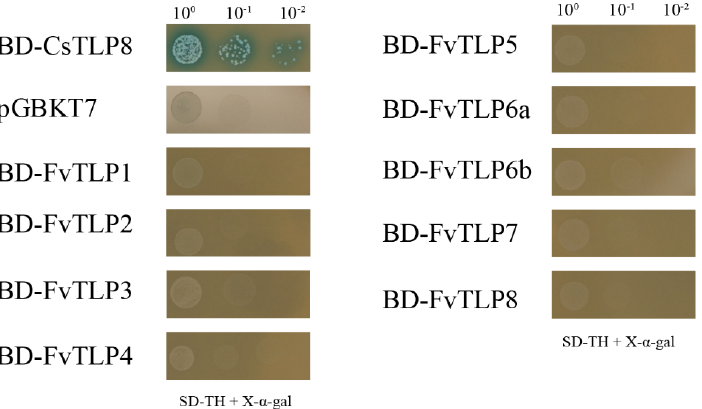
Figure 4. Subcellular localization of FvTLPs. FvTLP ‐ GFP and GFP were transiently expressed in tobacco epidermal cells and then observed with a confocal microscope. Cell nuclei were stained with DAPI.